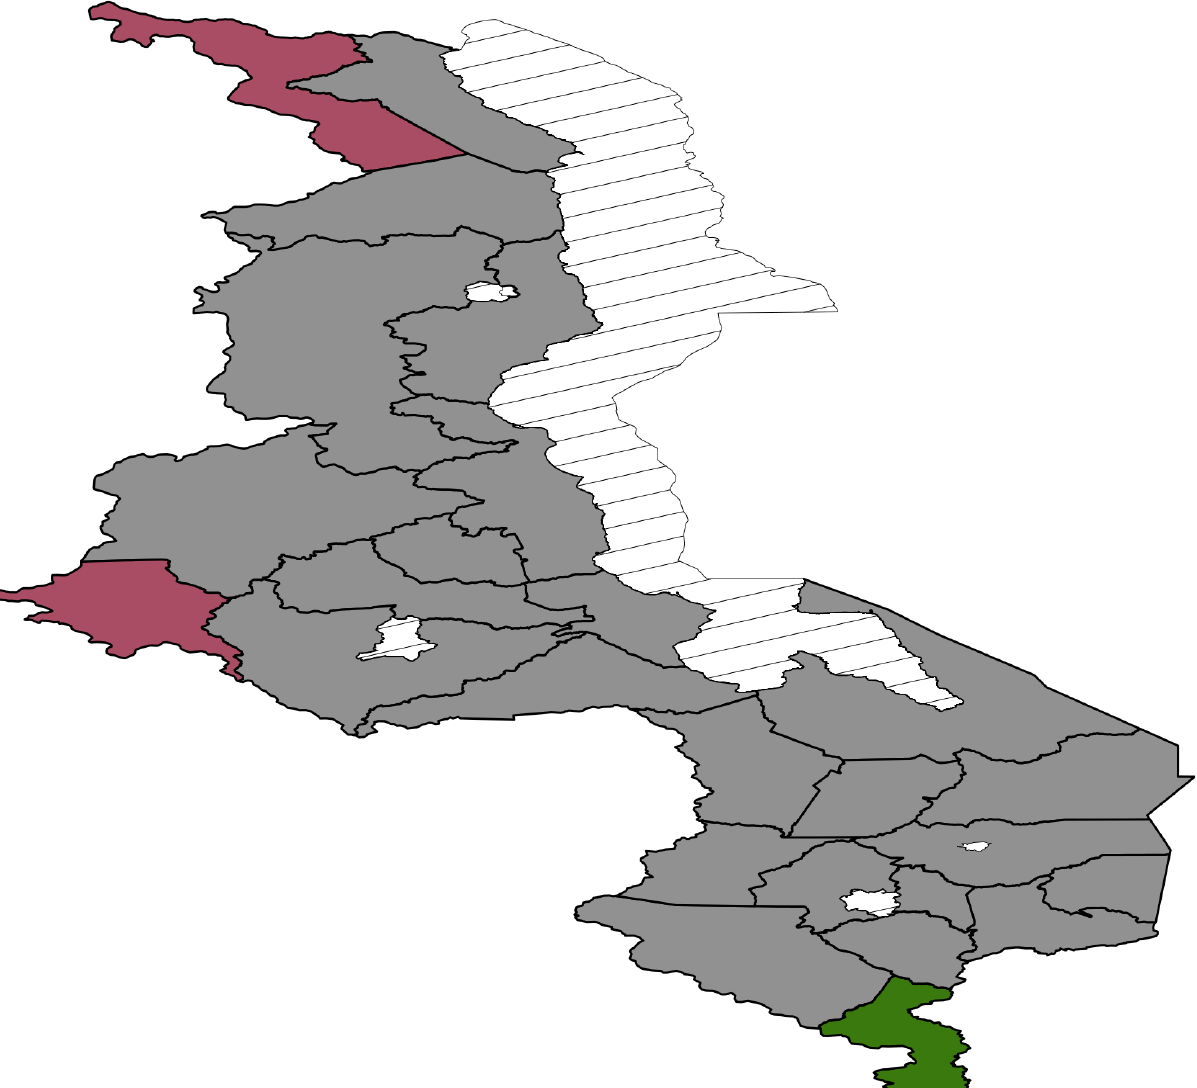
Fig 6. The 95% posterior credible intervals map for the spatial effects from the logistic model. Red means positive effect, green means negative effect and grey means insignificant effect.